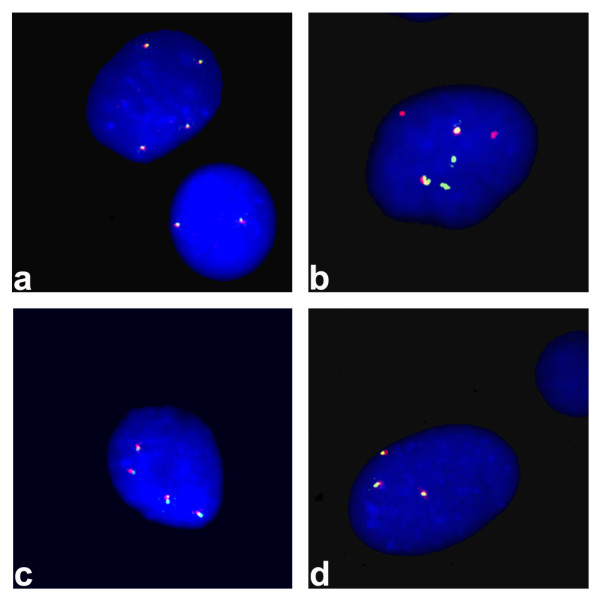
Fluorescence in situ hybridization. FISH with a home-brew dual color break-apart probe set for RET gene (5' labelled with Spectrum Orange and 3' labeled with Spectrum Green). Cells with unrearranged RET show intact red/green signals (one fused signal for each RET gene); cells with rearranged RET show probe signal split into its 5' (red signal) and 3' (green signal) portions (two discrete red and green signals for each rearranged RET gene). NTHY-ORI 3-1 representative nuclei with four (a, top) and two (a, bottom) copies of intact RET; TPC1 representative nucleus with two copies of intact RET (two red/green signals) and two copies of rearranged RET (two discrete red and green signals) (b); K1 representative nucleus with four copies of intact RET (c); B-CPAP repesentative nucleus with three copies of intact RET (d). Nuclei are counterstained with 4',6-diamidino-2-phenylindole.